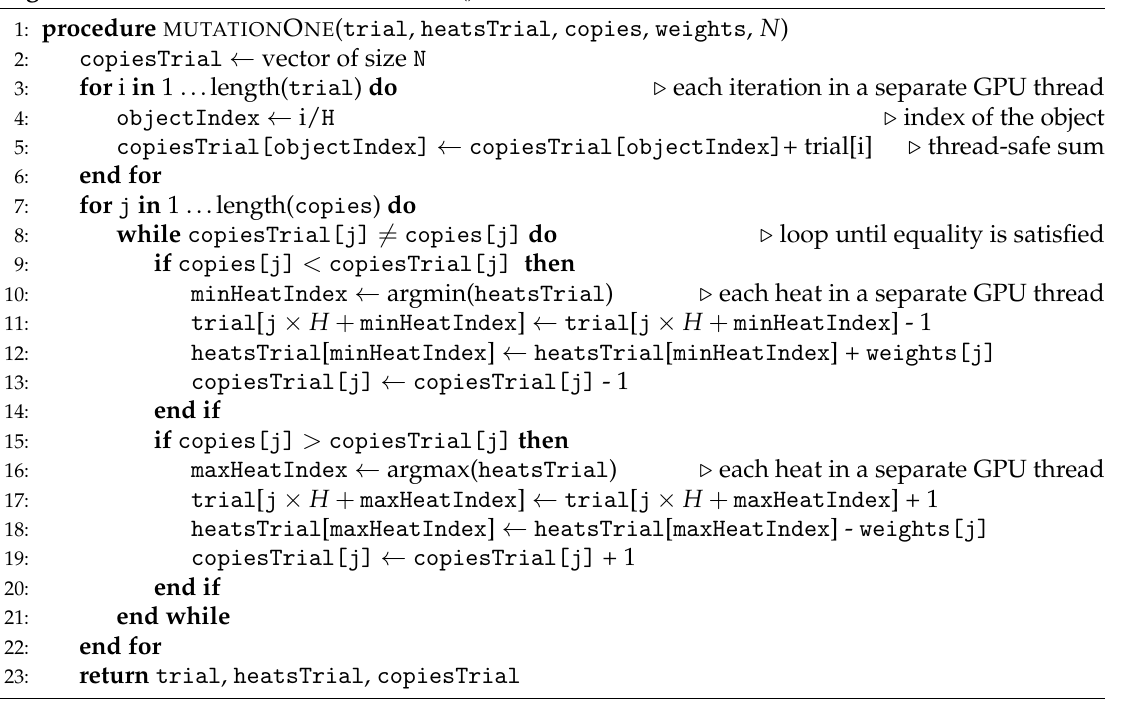
Algorithm 12 Discrete cGA: